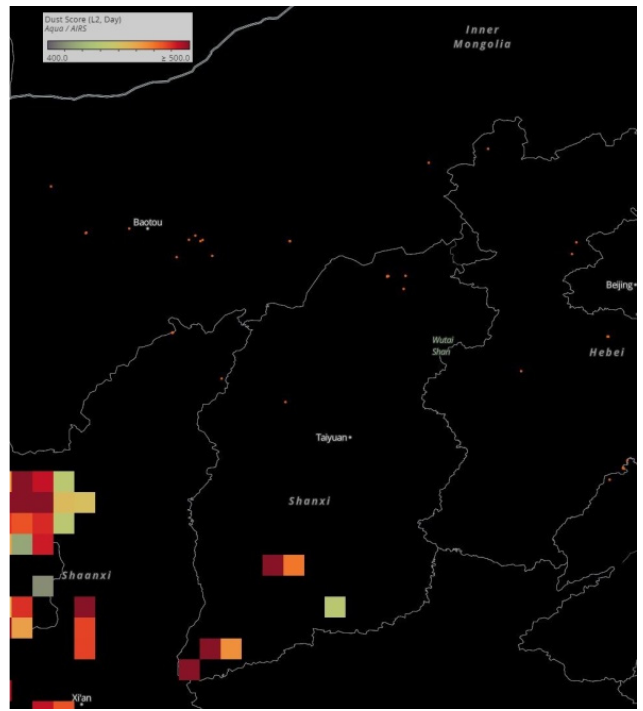
Figure 9. The MODIS fire and AIRS dust score distribution over northern China on 13 March 2020.